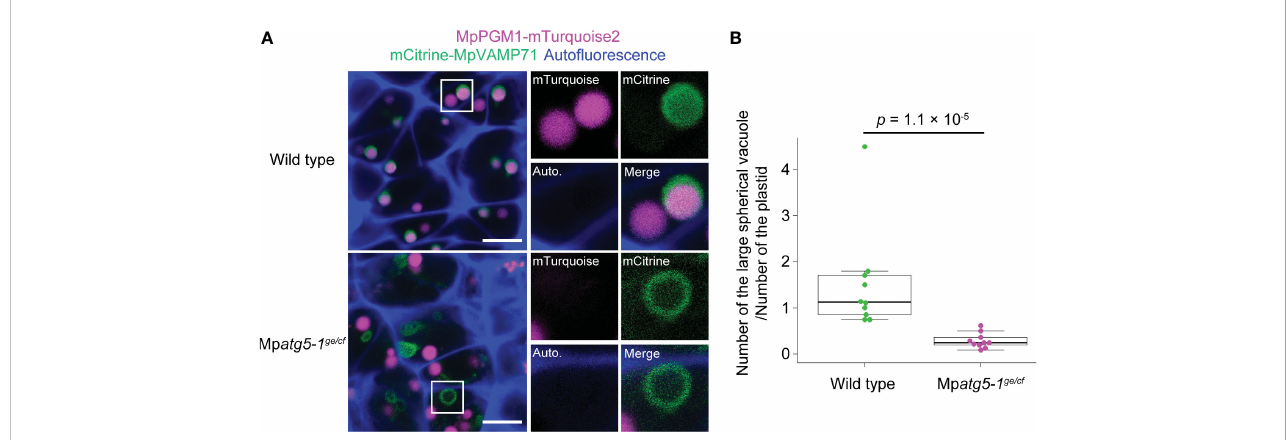
FIGURE 4 MpATG5-dependent vacuolar degradation of the plastid during spermiogenesis. (A) Confocal images of hand-sectioned antheridial cells of wild-type and Mp atg5-1 ge/cf mutant plants co-expressing MpPGM1-mTurquoise2 (magenta) and mCitrine-MpVAMP71 (green). The auto fl uorescence probably from auronidin (Berland et al., 2019) is shown in blue. 10 images (22.49 m m × 22.49 m m) were obtained for each genotype, and representative images are presented. The right two panels show the enlarged images of the boxed regions. Scale bars = 5 m m. (B) The number of large spherical vacuoles observed in the confocal sections. The vacuole number was normalized by the plastid number, because most of wild-type and Mp atg5 spermatozoids possess a single plastid (see Figures 2). Vacuoles and plastids in 10 images obtained in (A) were counted for each genotype. The boxes and solid lines in the boxes indicate the fi rst and third quartiles and median, respectively. The upper and lower whiskers are drawn at the greatest value smaller than 1.5× the IQR above the third quartile and the smallest value greater than 1.5× the IQR below the fi rst quartile, respectively. The p values obtained by the Wilcoxon rank-sum test is